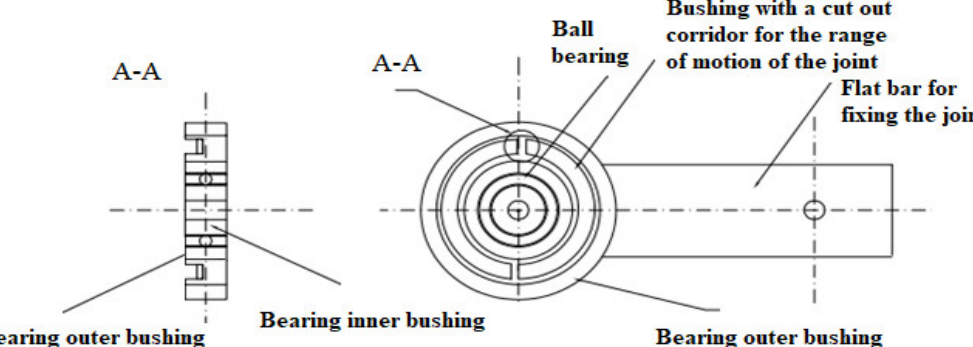
Figure 9. View of the left side of the elbow joint of the anthropometric crash test dummy.